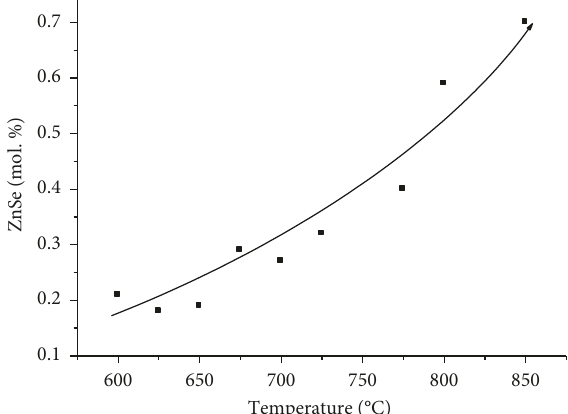
Figure 4: Dependence of the solubility of ZnSe in Sn on temperature